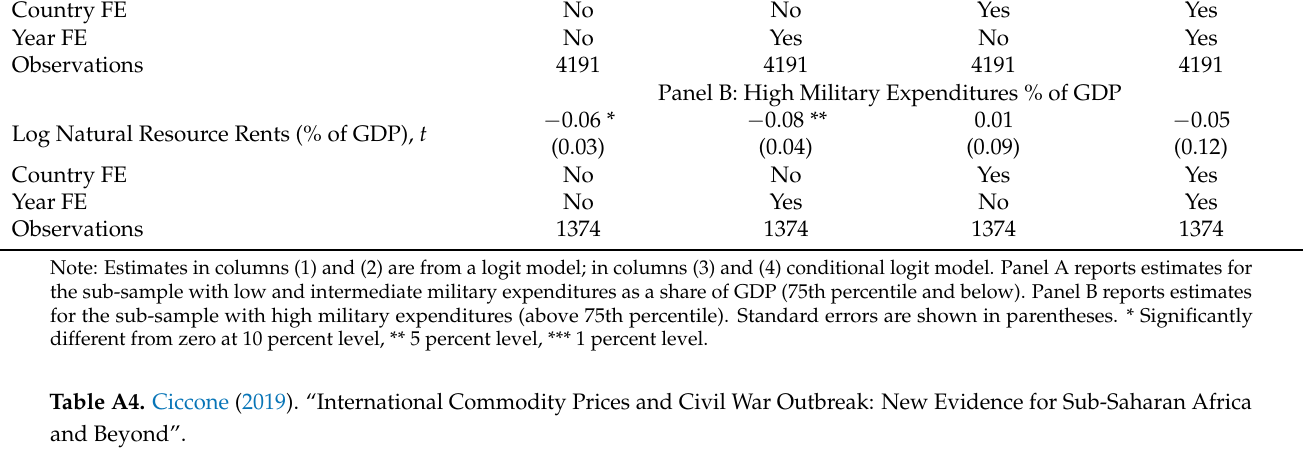
Panel B: High Military Expenditures % of GDP